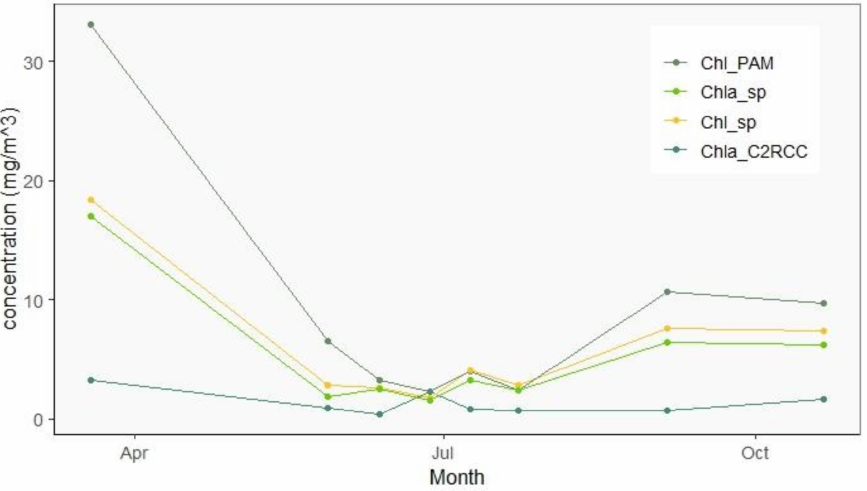
Figure 2. Time-series plot of the concentration values measured (daily mean of the five sampling sites).